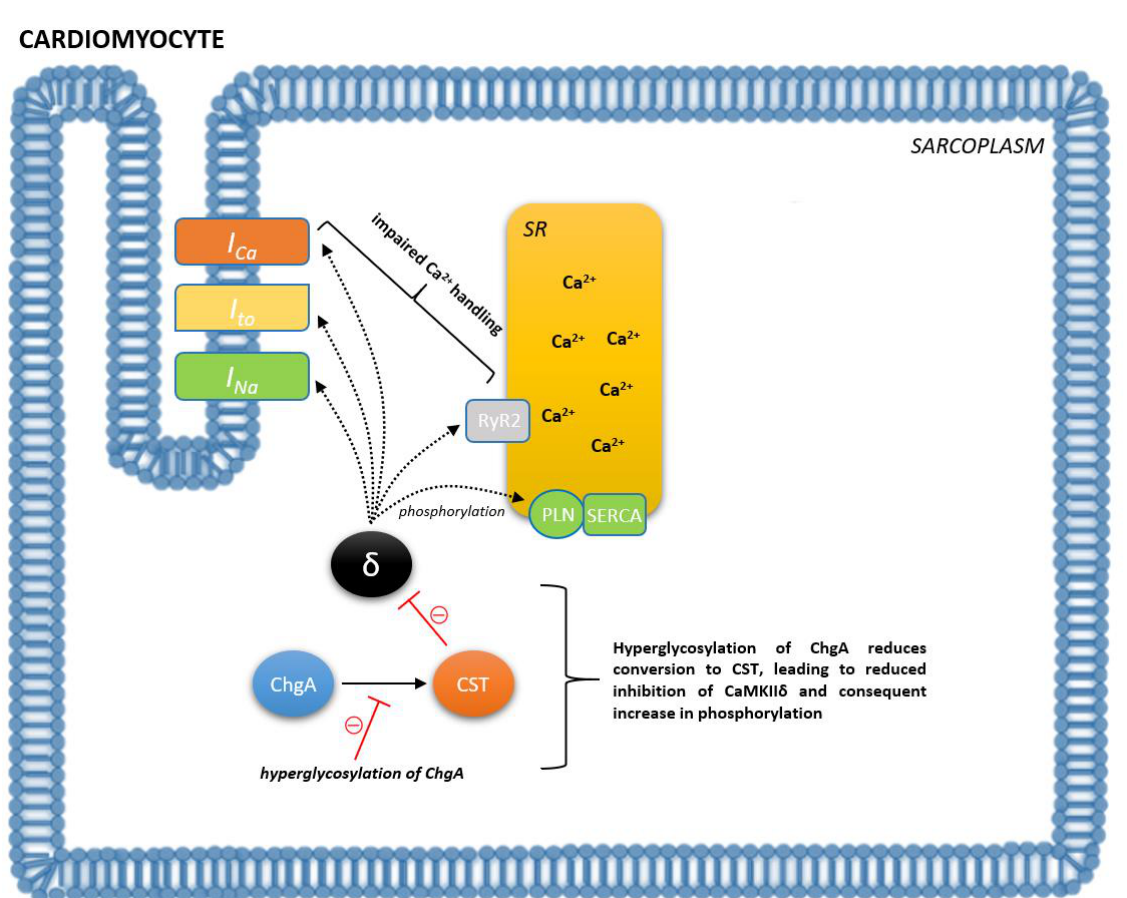
Figure 2. Putative mechanism by which catestatin contributes to pathophysiology of heart failure (HF). In the setting of HF, hyperglycosylated ChgA cannot be sufficiently cleaved by CST, which leads to reduced inhibition of CaMKIIδ and CaMKIIδ -mediated phosphorylation of cardiac proteins. As a result of increased phosphorylation, calcium handling in cardiomyocytes becomes impaired and dampens cardiac function. Abbreviations: ChgA: chromogranin A; CST: catestatin; CaMKIIδ (δ): the multifunctional Ca 2+ /calmodulin-dependent protein kinase II delta; SR: sarcoplasmic reticulum; RYR2: ryanodine receptor 2; SERCA: sarco/endoplasmic reticulum Ca 2+ -ATPase; PLN: phospholamban.